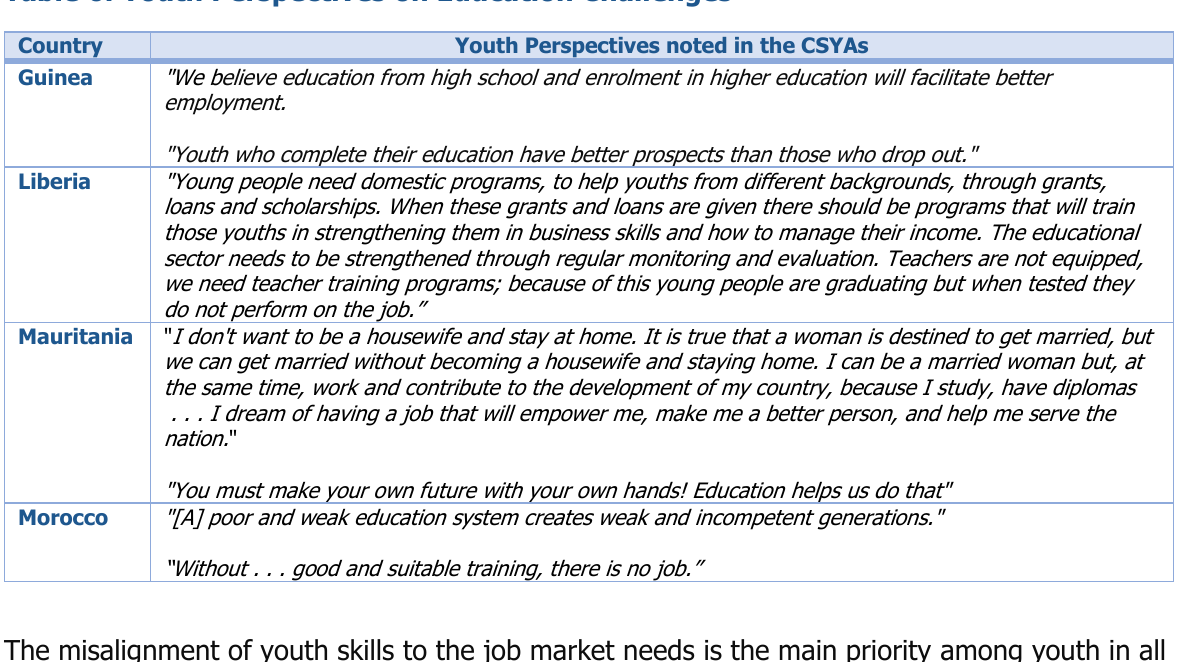
Table 6. Youth Perspectives on Education